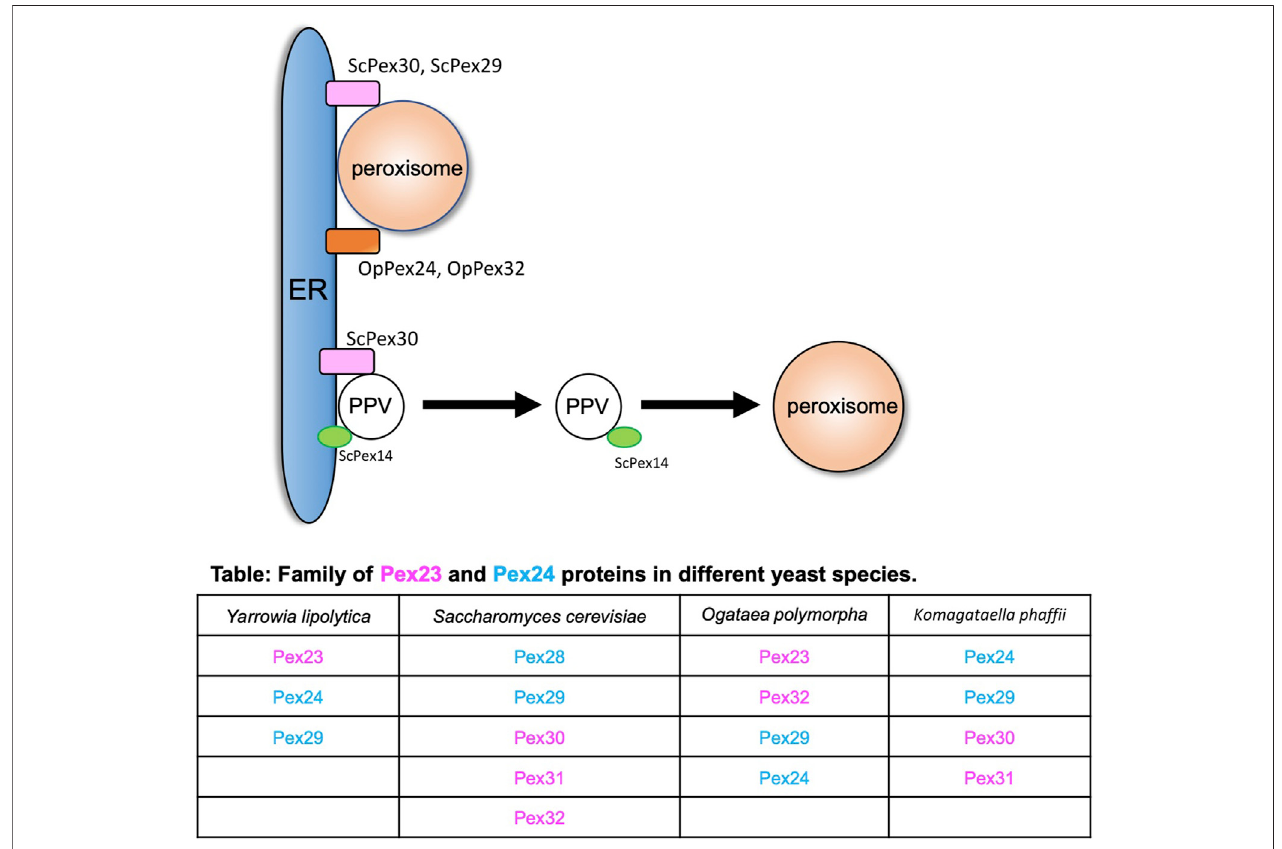
FIGURE1| Peroxisome – ERcontactsites.PeroxisomeandPPVscontacttheERatsubdomainsenrichedwiththePex23andPex24proteinfamilies.ScPex30and ScPex29andOpPex24andOpPex32areattheER – peroxisomecontactsites.ScPex30isatERsubdomainswhereScPex14-containingnascentPPVsareformed.The table contains the family of Pex23 (magenta) and Pex24 (blue) proteins in different yeasts.